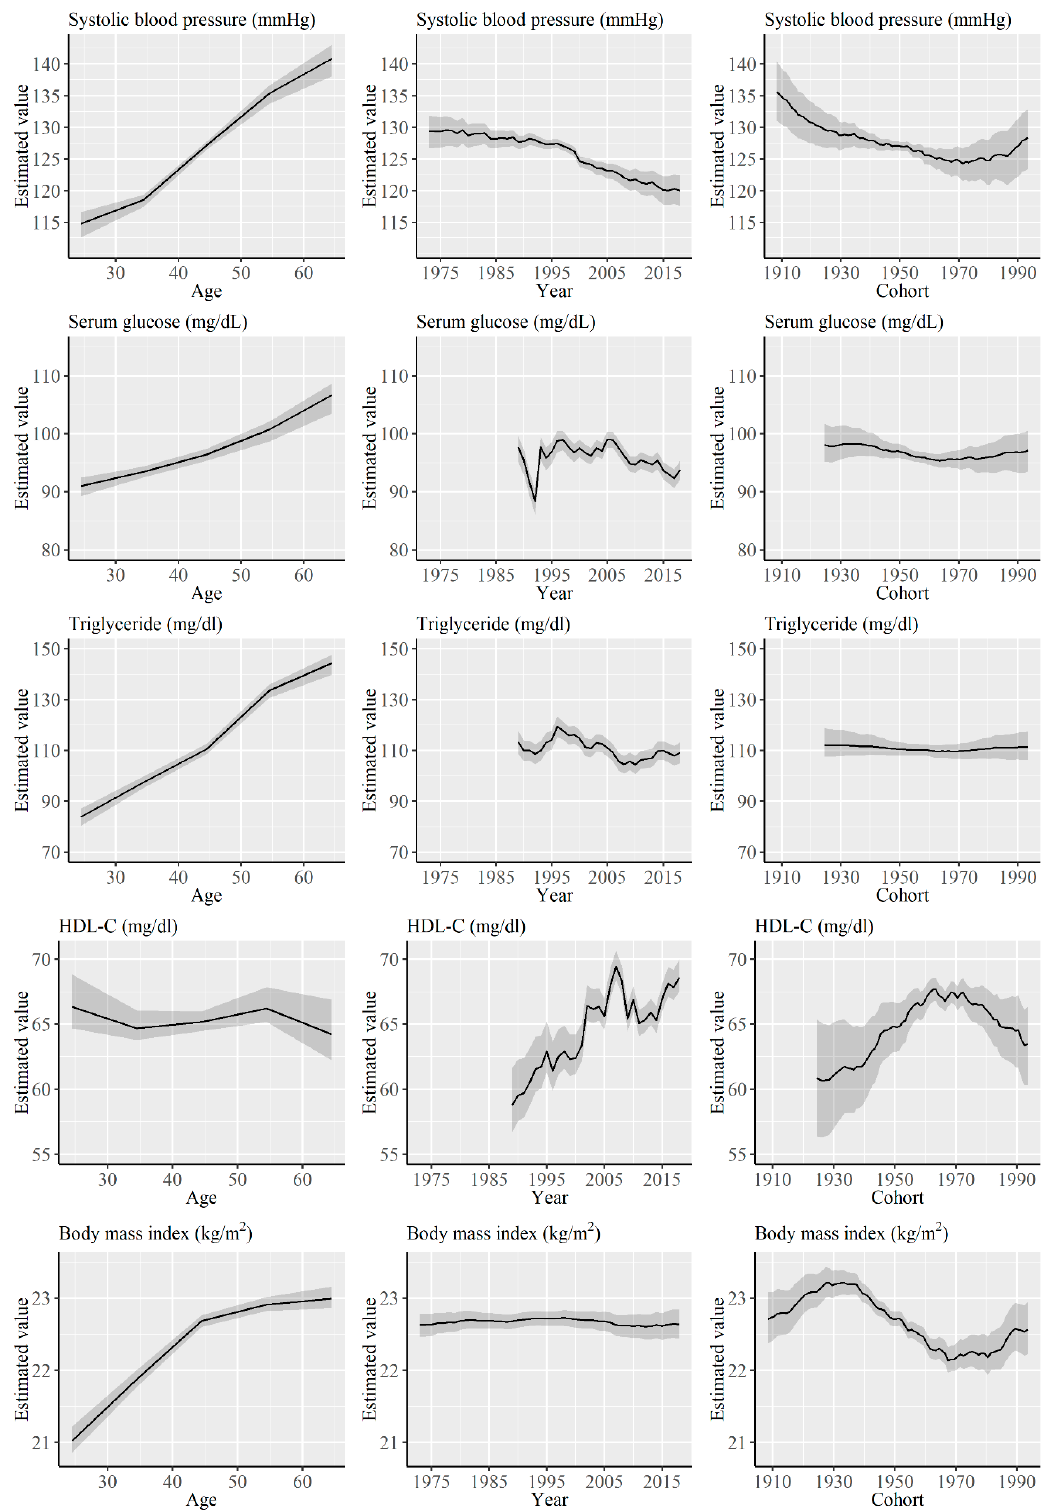
Figure 4. Results of the Age-Period-Cohort (APC) analysis of systolic blood pressure, serum glucose, triglyceride, high-density lipoprotein cholesterol, and body mass index for women. Solid lines signify estimates of each effect, and the shadings show 95% credible intervals of each estimates.